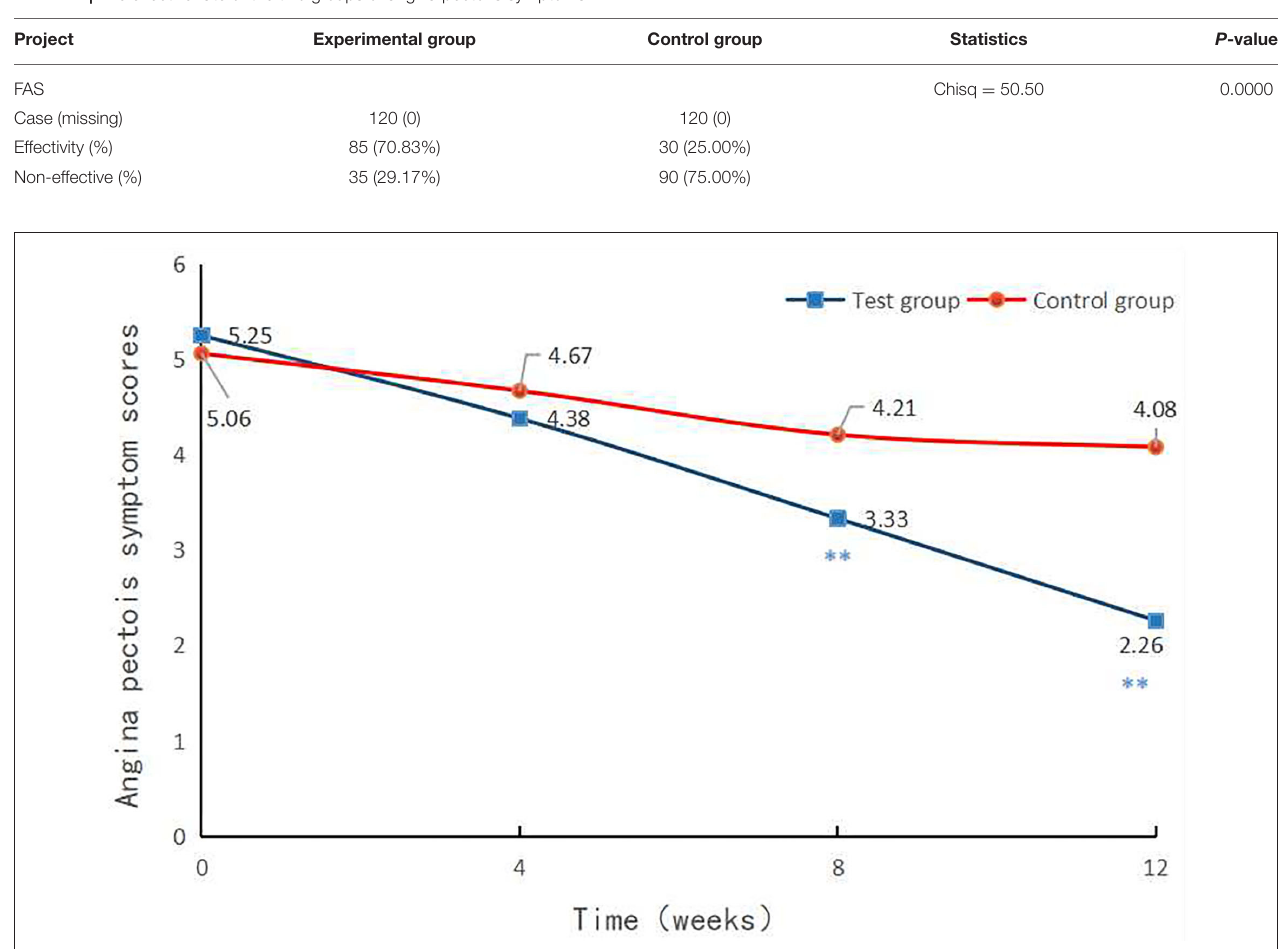
TABLE 7 | The effective rate of the two groups of angina pectoris symptoms.